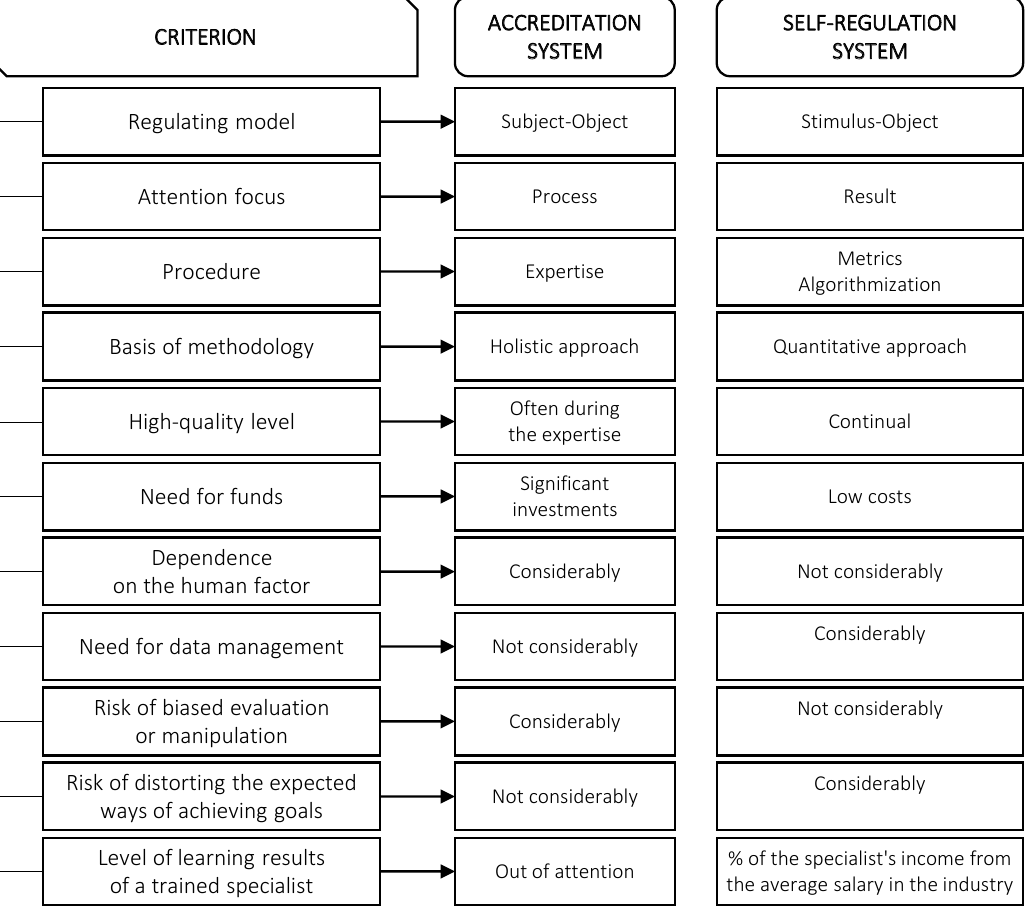
Figure 2. Main differences in the self-regulation and accreditation system of external assurance and improving the quality of higher education in